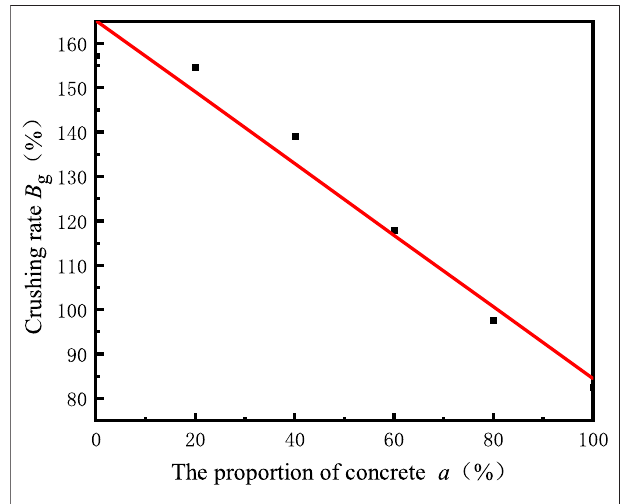
FIGURE 3 | The proportion of concrete vs crushing